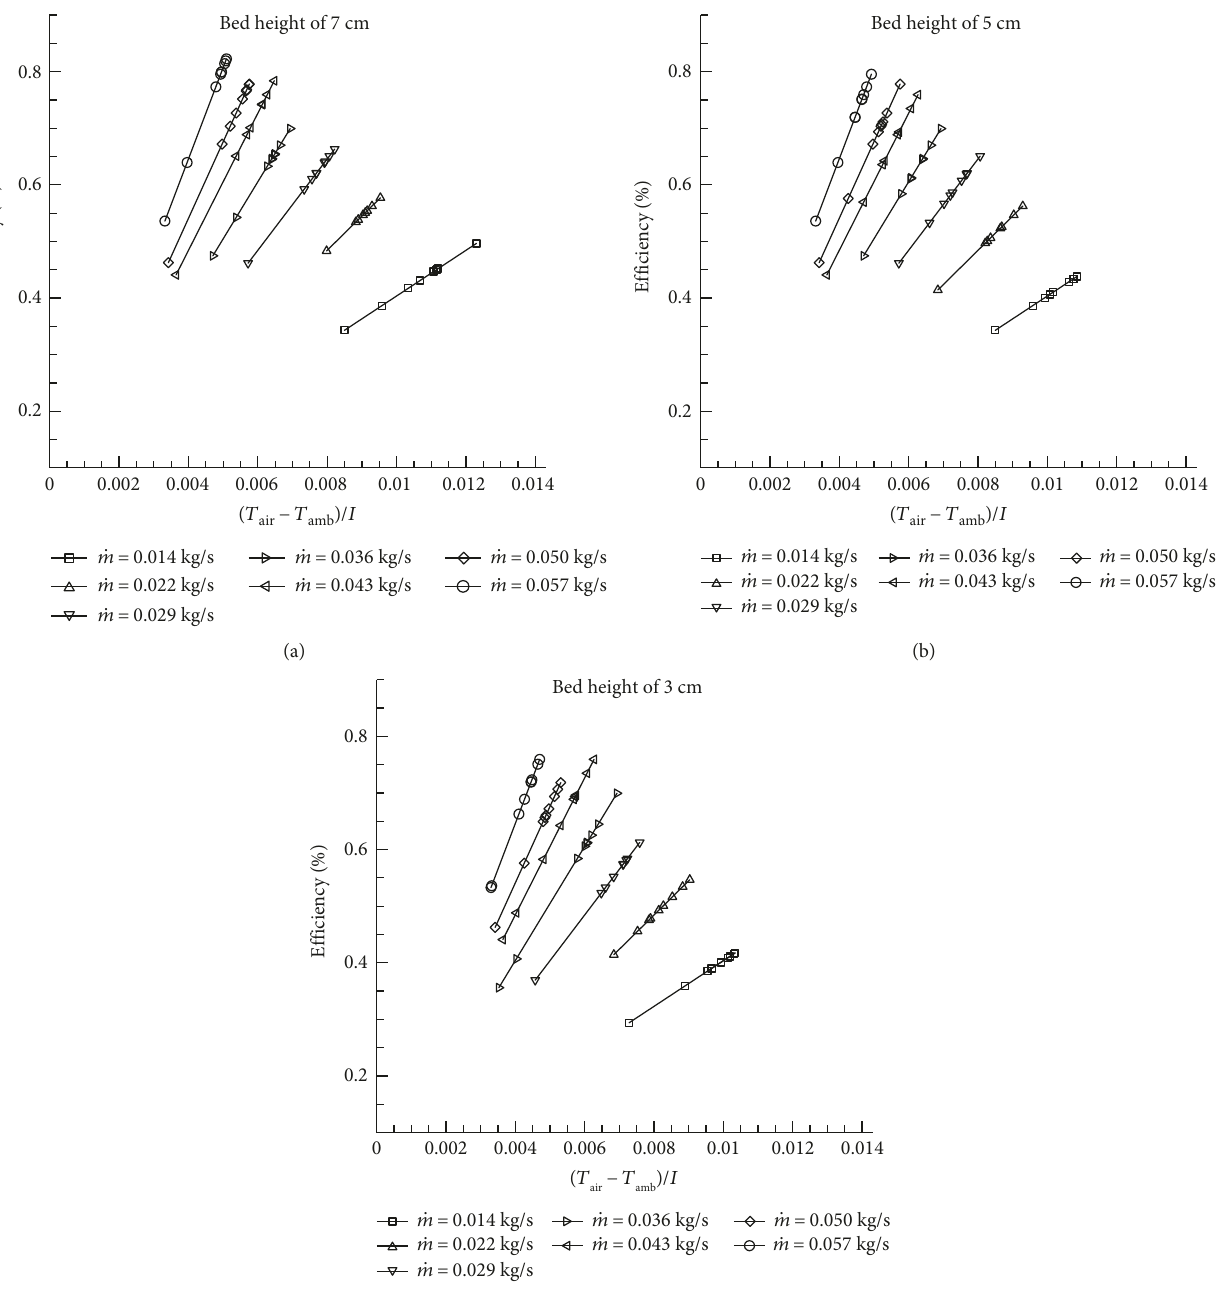
Figure 12: E ffi ciency versus T (a) 7cm, (b) 5 cm and (c) 3